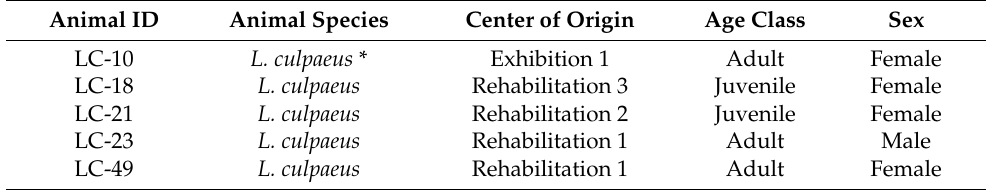
Table 3. Epidemiologic characteristics of the B. canis seropositive native foxes. Animal ID Animal Species Center of Origin Age Class